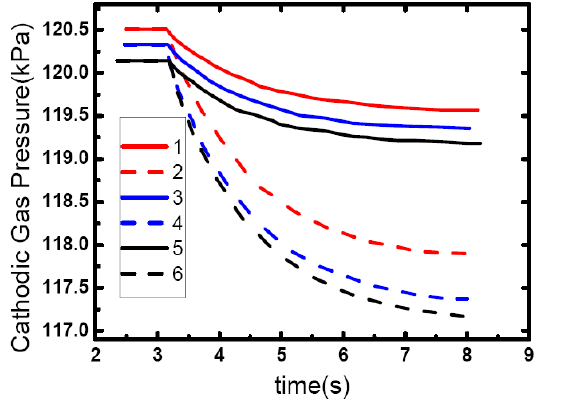
Figure 13. Cathode gas dynamic response while in direct loading-up. (1) Channel inlet when current is changed from 60 A to 82 A. (2) Mid-channel when current is changed from 60 A to 82 A. (3) Channel outlet when current is changed from 60 A to 82 A. (4) Channel inlet when current is changed from 60 A to 126 A. (5) Mid-channel when current is changed from 60 A to 126 A. (6) Channel outlet when current is changed from 60 A to 126 A.